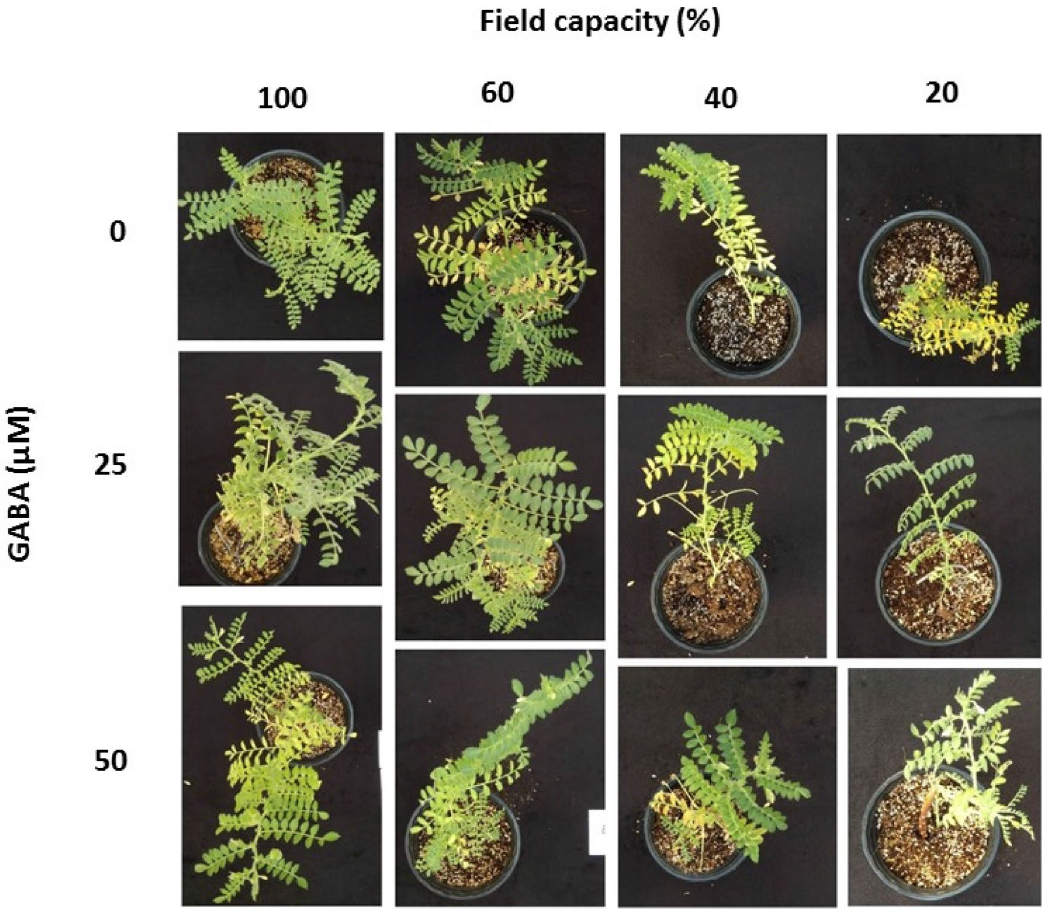
Figure 2. Representative images of cv. Azad (sensitive) chickpea plants receiving exogenous application of γ-aminobutyric acid (GABA) at different concentrations (0, 25 and 50 μM) under different watering levels (100, 60, 40 and 20% field capacity) during cultivation.